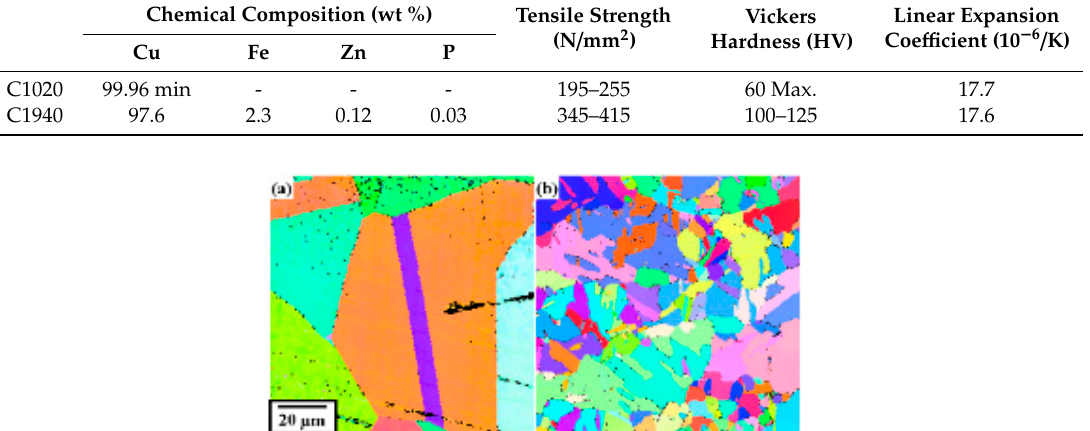
Figure 2. Orientation maps of ( a ) C1020 and ( b ) C1940 substrates. Table 2. Properties of copper substrates.